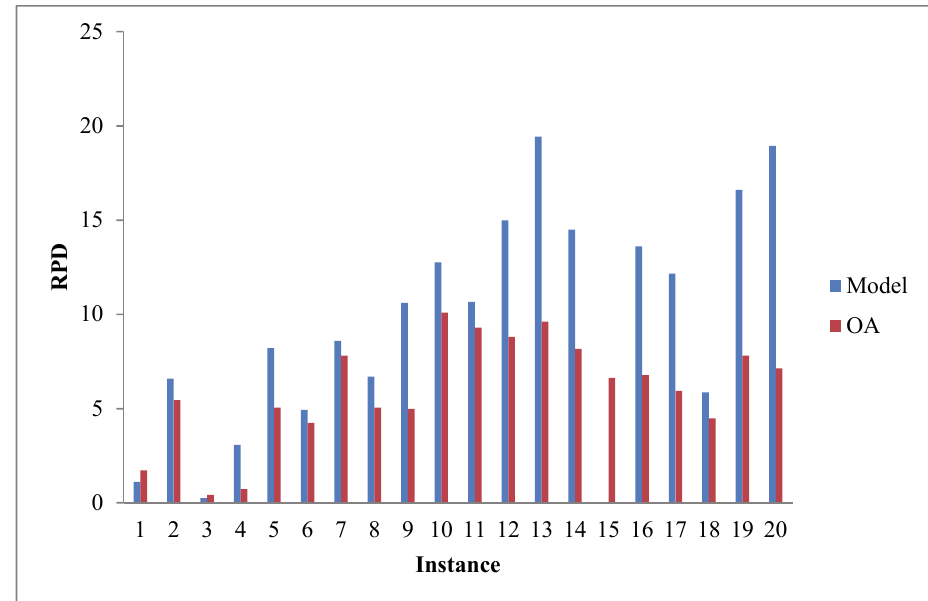
Fig. 2. Comparing the performance of the external approximation algorithms and the mathematical